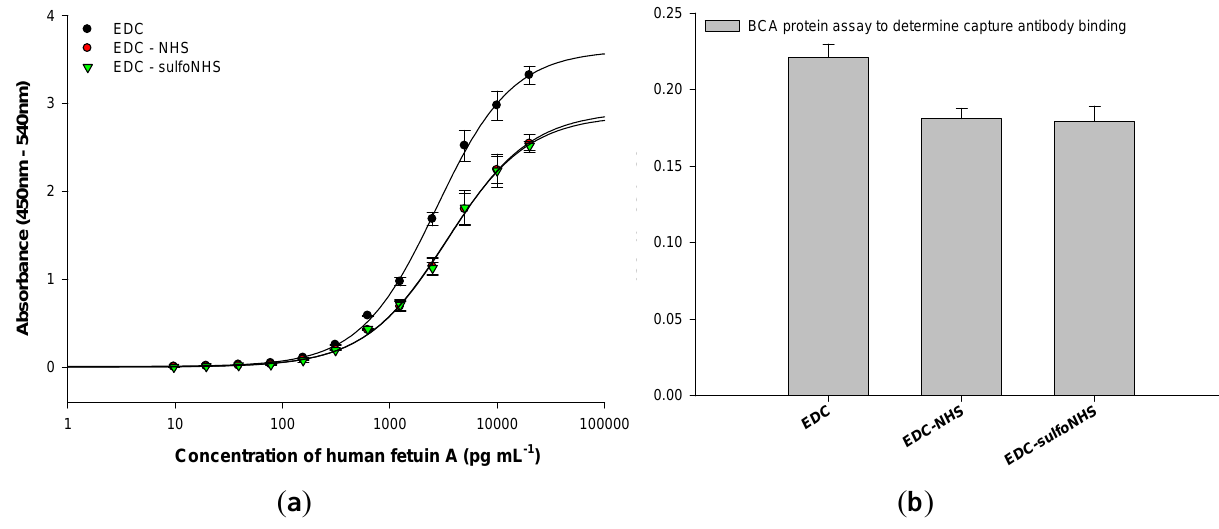
Figure 3. ( a ) HFA sandwich sandwich enzyme linked immunosorbent immunoassay (ELISA) using various EDC-based strategies for crosslinking anti-HFA antibodies to APTES-functionalized 96-well microtiter plates (MTP); ( b ) bicinchoninic acid (BCA) protein assay to determine the amount of anti-HFA antibody bound to MTP by various strategies. All experiments were done in triplicate. The errors bars represent standard